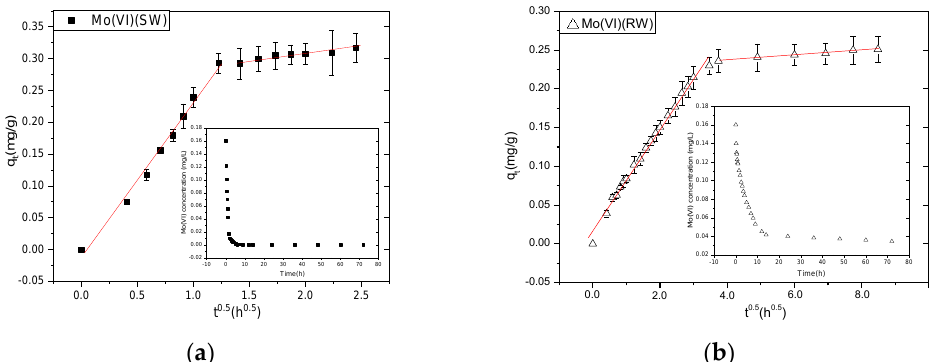
Figure 2. Adsorption kinetics of Mo(VI) on NZVI / AC. ( a ) Intraparticle di ff usion model of the kinetics of Mo adsorption onto NZVI / AC in SW. Right inset shows original data of Mo(VI) adsorption with respect to time in SW. ( b ) Intraparticle di ff usion model of the kinetics of Mo adsorption onto NZVI / AC in RW. Right inset shows original data of Mo(VI) adsorption with respect to time in RW. Conditions: pH = 8.1, 20 × 40 mesh particle size, 150 rpm, adsorbent dosage in simulation water = 0.5 g / L, t = 72 h, T = 298 K, C 0 SW = 0.1603 mg / L, C 0 RW = 0.1603 mg /